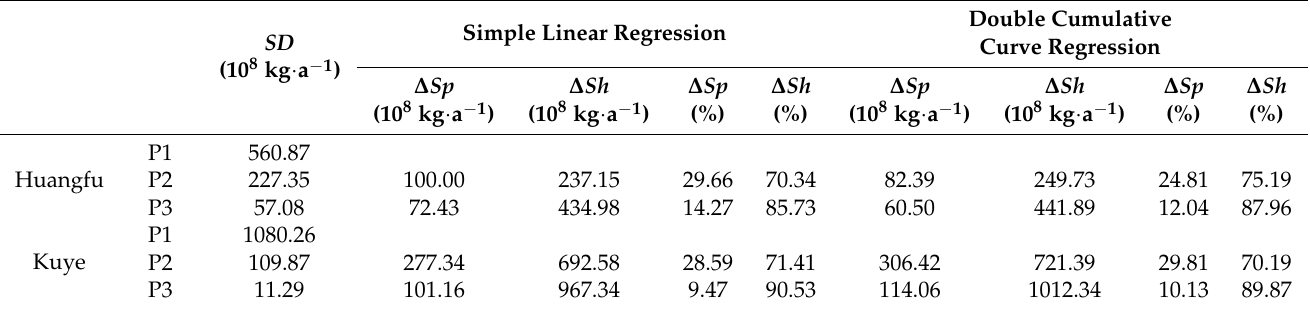
Table 5. Estimates of sediment discharge reductions attributed to rainfall erosivity and human